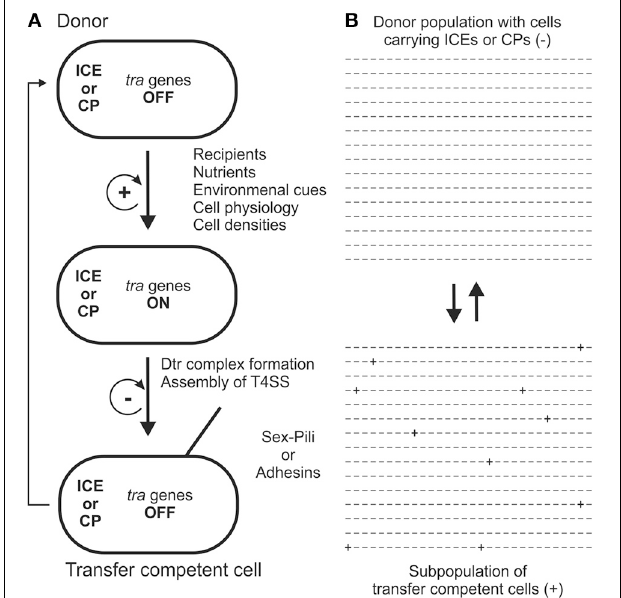
FIGURE 2 | Two models for the development of transfer competence in single cells (A) and populations (B) are shown. In single cells (A) tra genes are turned ON by a variety of stimuli. A positive feedback loop ensures that, once initiated, cells proceed to transfer competence, involving formation of the Dtr complex and assembly of the T4S apparatus. In transfer competent cells, tra genes are switched OFF, mediated by a negative feedback loop. Eventually, transfer competence is lost by transition to unfavorable conditions. In unstructured, well-mixed populations (B) only a few donor cells (indicated by + signs) develop transfer competence, thereby minimizing the fitness cost for the population. For examples, detailed descriptions and discussions, the reader is referred to the section “How and when to turn DNA transfer genes ON” in the main text of this